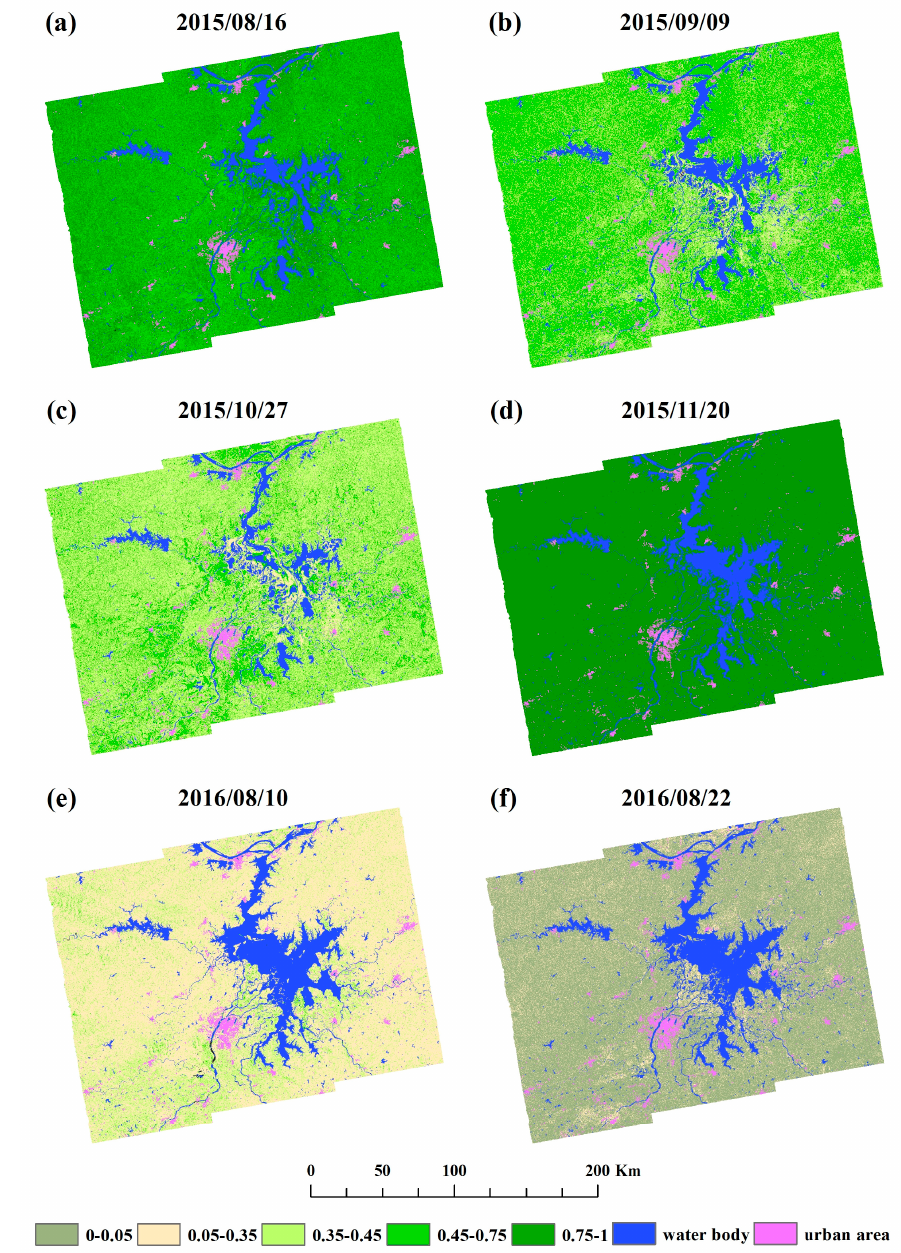
Figure 7. Soil moisture index maps for six selected dates.